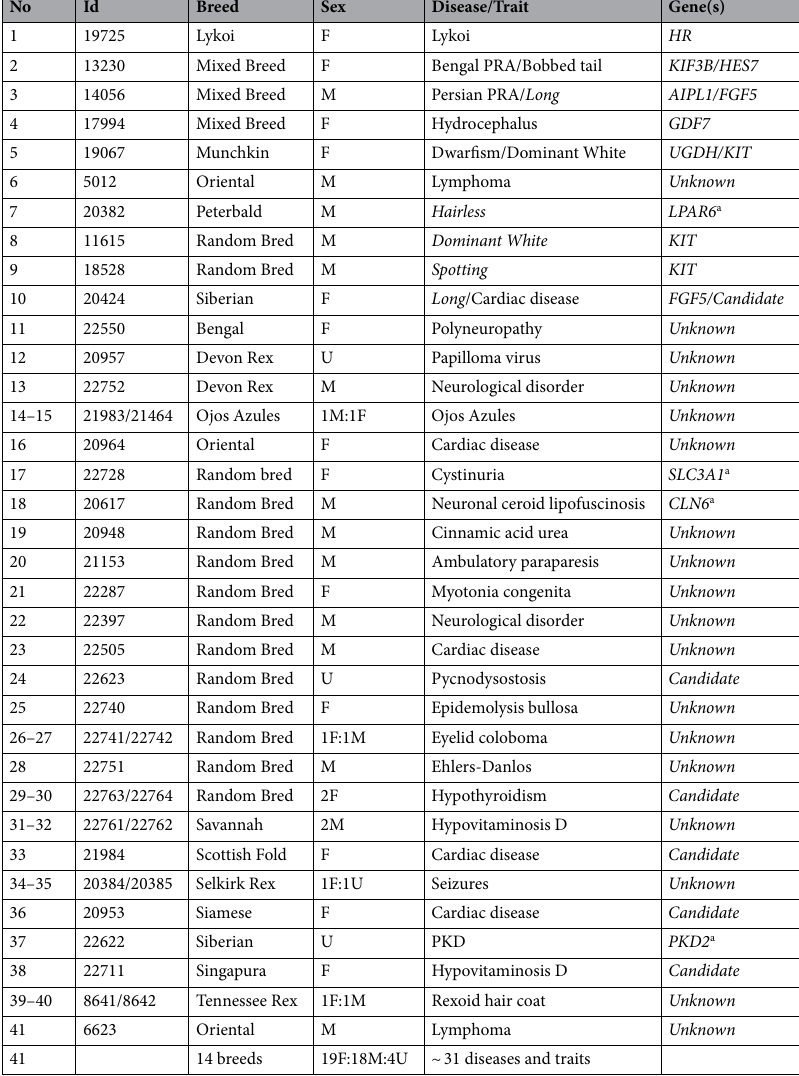
Table 1. Description and diseases of 41 cats for WES evaluation. A complete description of diseases and traits for entire cohort. Candidate genes are potential genes that been identified with less evidence of a causal mutations. U unknown sex, F female, M male. a Mutations as tentative causal variants for diseases presented.